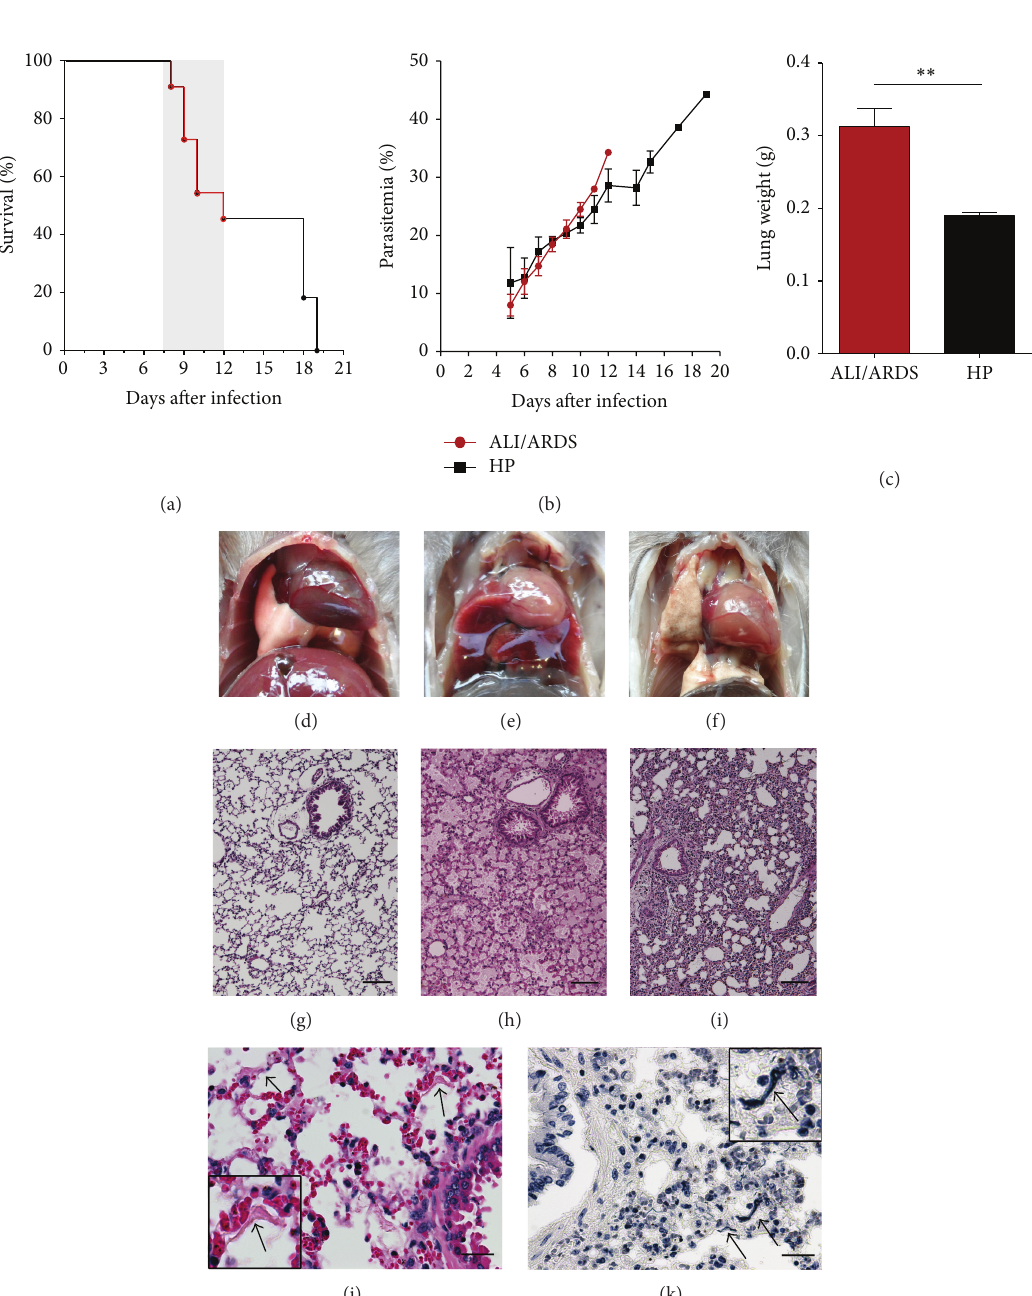
Figure 1: Infection of DBA/2 mice with P. berghei ANKA constitutes a rodent model for malaria-associated ALI/ARDS. (a) Survival and (b) parasitemia curves from the ALI/ARDS and HP mice over time. The red line was the mice that died with ALI/ARDS. The gray area represents the period when the mice die of ALI/ARDS. The data presented are representative of 13 independent experiments; 𝑛 = 10 – 12 mice/experiment. (c) The lungs of mice that died with ALI/ARDS weighed 40% more than the lungs of mice that died with HP ( ∗∗ 𝑃 ≤ 0.005 ; Mann-Whitney test of lung weights are representative of four separate experiments). Data ((b) and (c)) represent means and SEM; 𝑛 = 10 – 12 mice/experiment. (d) Representative pictures of a NI mouse, (e) an infected mouse that died with ALI/ARDS showing hemorrhagic lungs and a large amount of pleural effusion, and (f) a mouse that died with HP showing pale and grayish lungs and no pleural effusion. Representative histopathologicalimagesoflungsfrom(g)NImiceandinfectedDBA/2micethatdiedwith(h)ALI/ARDSand(i)HPonthe10thand21stdays after infection, respectively. The arrow points to the hyaline membranes in the lungs of the DBA/2 mice that died with (j) ALI/ARDS stained with hematoxylin-eosin and (k) stained with phosphotungstic acid hematoxylin. The bar corresponds to 100 𝜇 m. HP: hyperparasitemia; ALI/ARDS: acute lung injury/acute respiratory distress